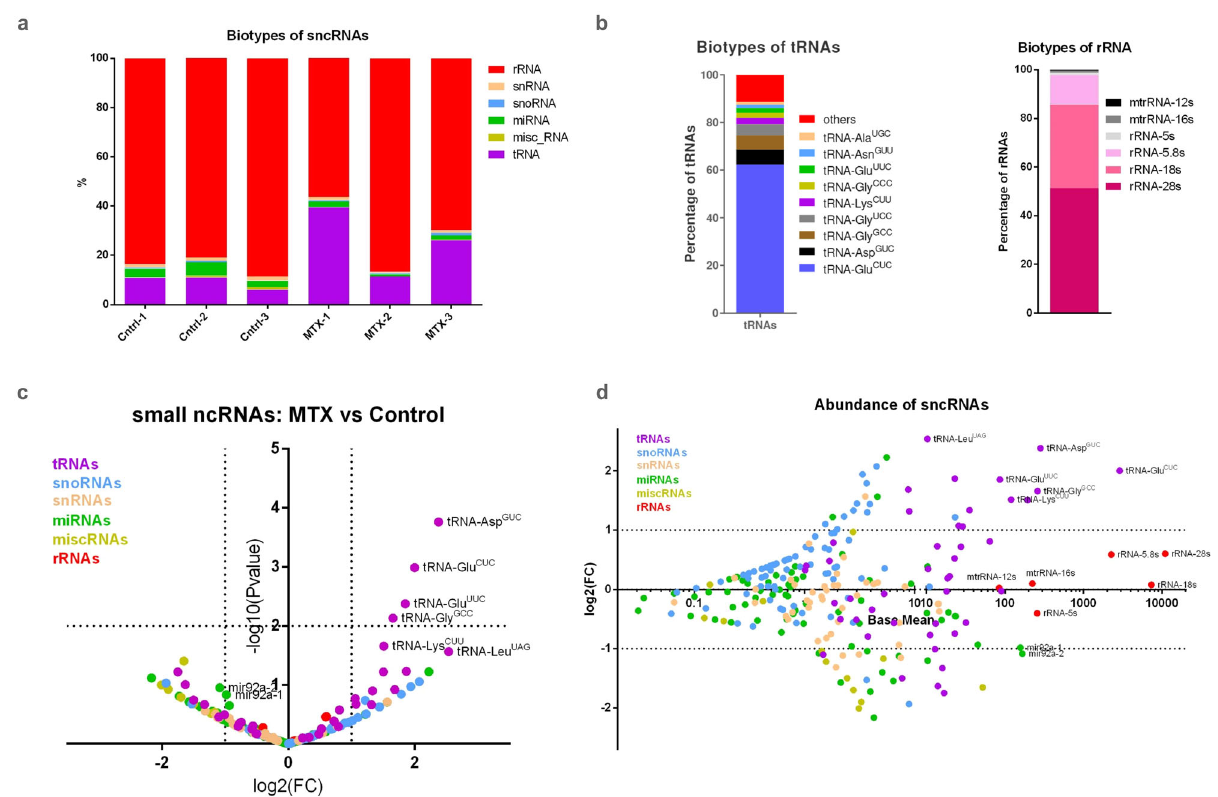
Fig. 3 | Paternal MTX injection alters sperm sncRNAs. a Histogram representing the comparison from sperm sncRNA on control (Ctrl1-3) and 10MTX (MTX-1-3) treatedmales. b HistogramdisplayingbiotypesoftRNAsand rRNAsfromspermof MTX treated males. See also Supplementary Data 1 for a and b . c Volcano plot of depicting the fold changes in sperm sncRNAs identi fi ed as being differentially